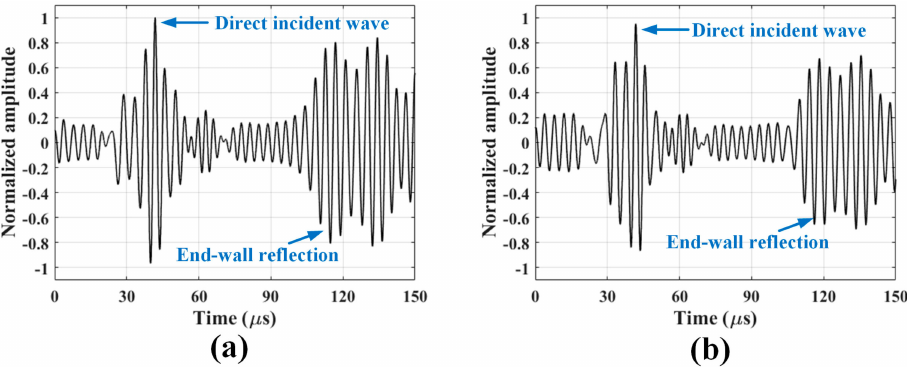
Figure 6. Normalized SH wave signals taken at ( a ) room temperature and ( b ) 121 ◦ C, with respect to the peak amplitude of the direct incident wave at room temperature.